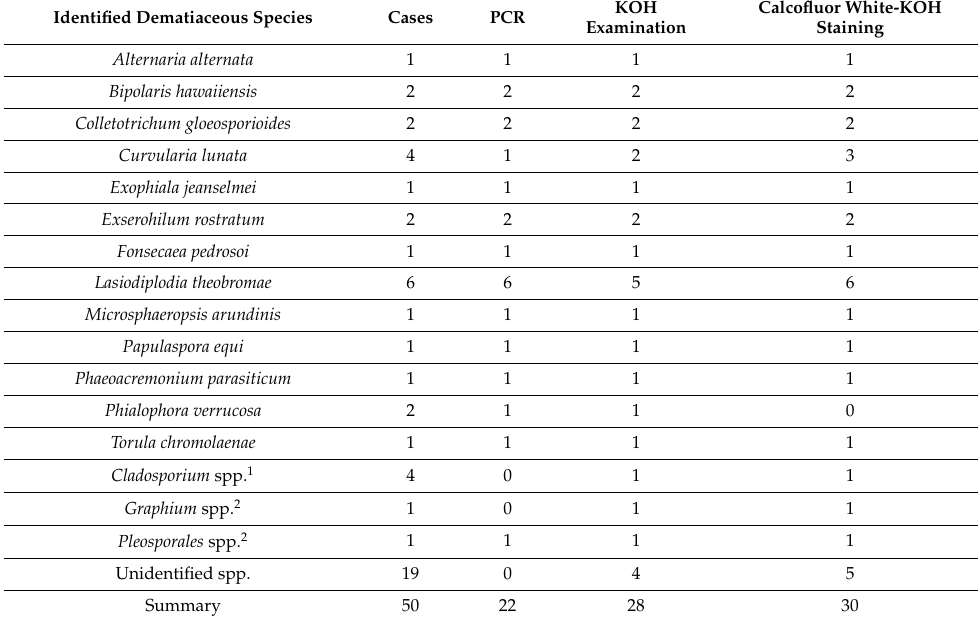
Table 4. Identification of dematiaceous species using various techniques ( N = 50).